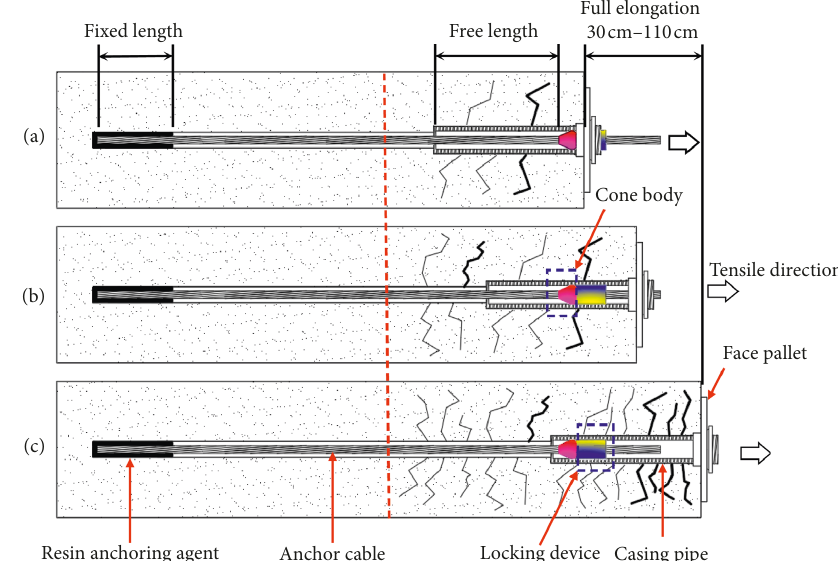
Figure 10: Working principle of the NPR anchor cable. (a) Installation of the NPR anchor cable. (b) Working state when the rock deforms. (c) Rock deformation at full elongation of the NPR anchor